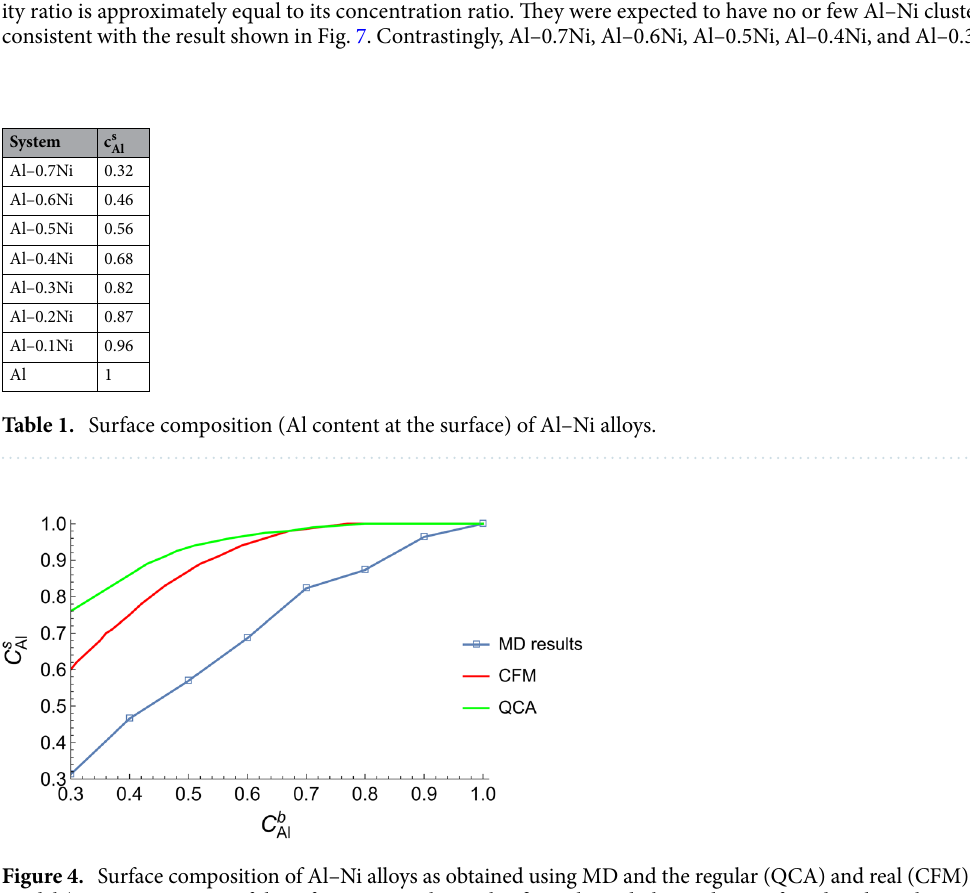
Figure 4. Surface composition of Al–Ni alloys as obtained using MD and the regular (QCA) and real (CFM) model (For interpretation of the references to color in this figure legend, the reader is referred to the web version of this